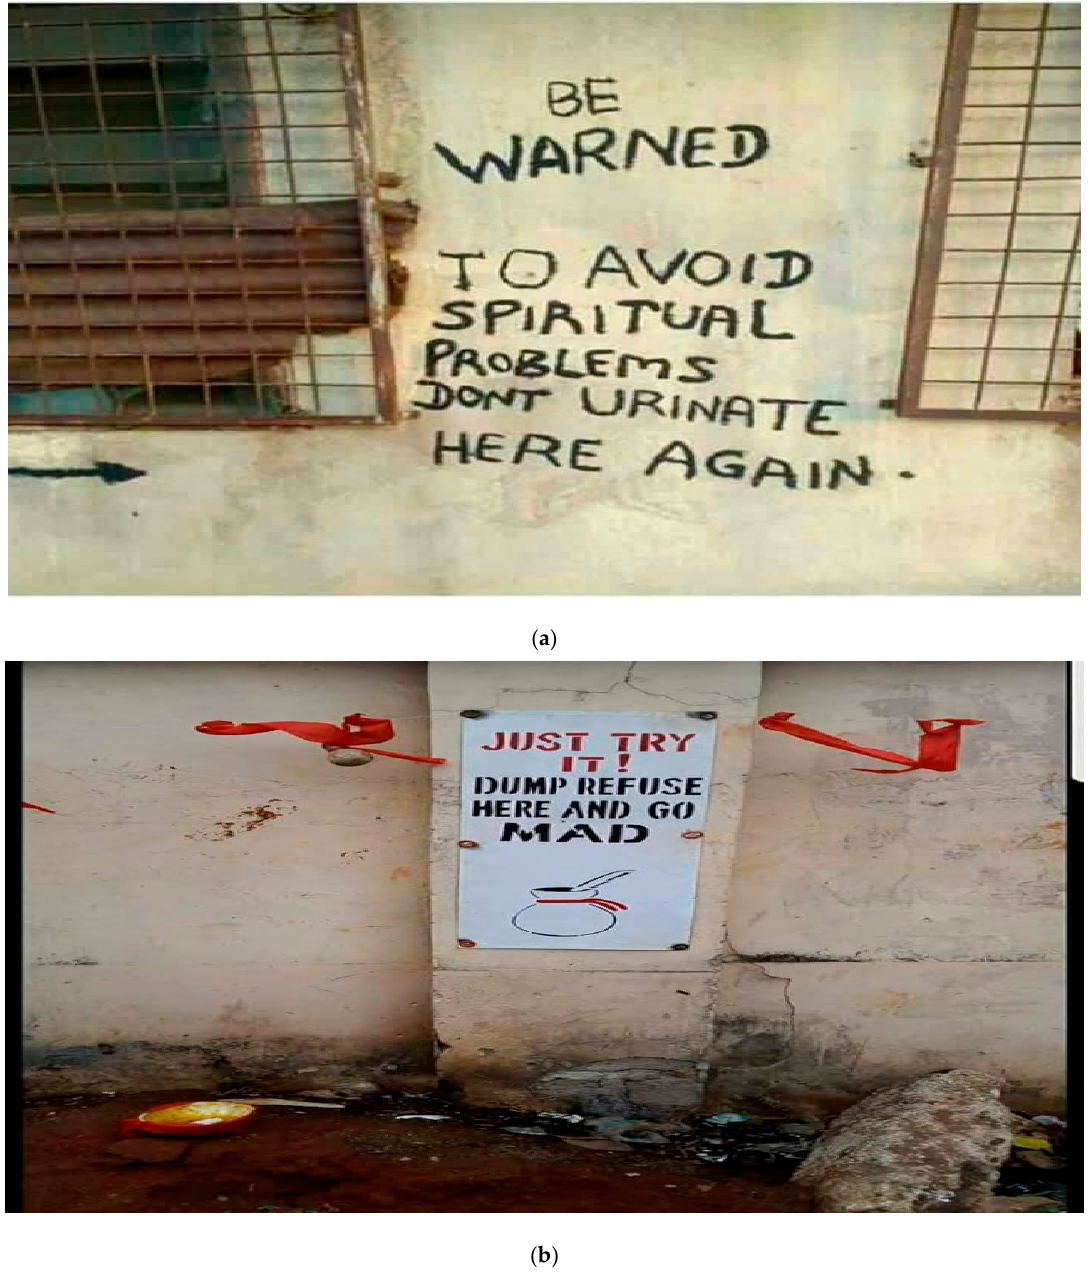
Figure 1. ( a ) Reflections of Escapelessness, ( b ) Reflections of Escapelessness.